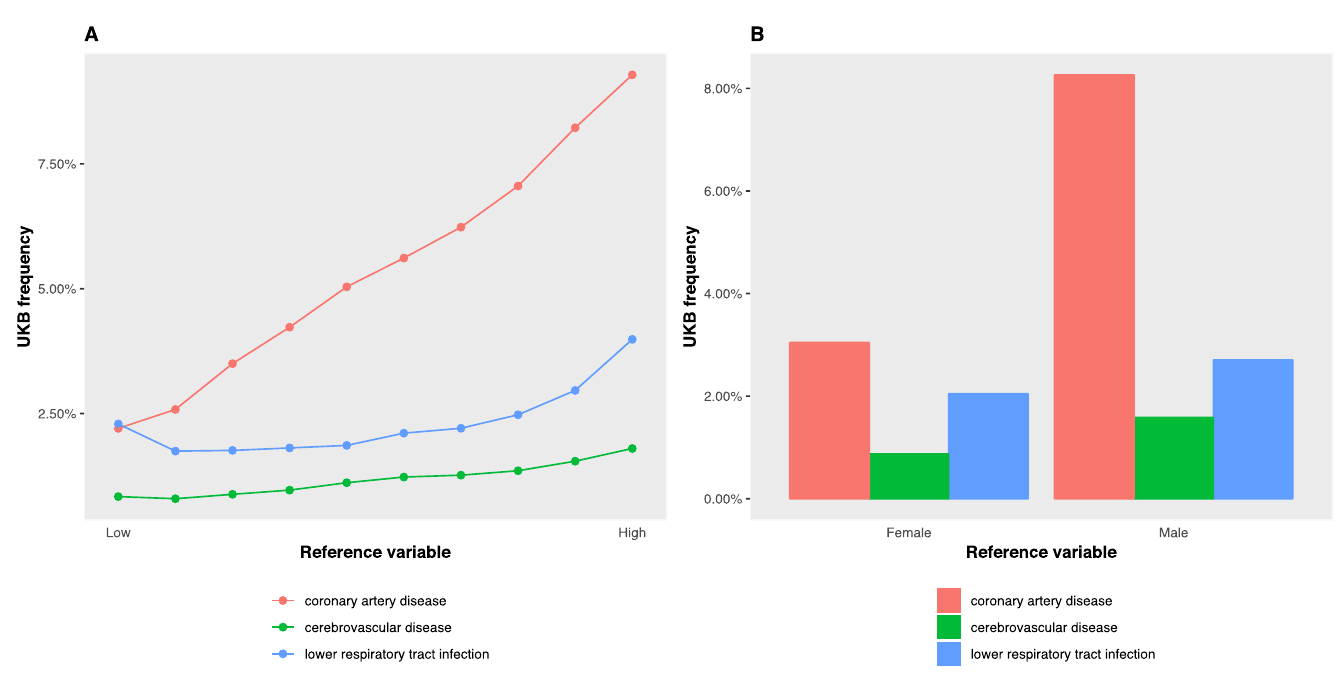
Fig 2. UKB disease frequency by BMI (quantitative) and sex (categorical) reference traits. In panel A the reference trait is body mass index, set with the ukb_icd_freq_by argument reference.var = "body_mass_index_bmi_f21001_0_0". Disease frequency is calculated within 10 approximately equal-sized groups (n. group = 10). In Panel B the reference trait is sex, reference.var = "sex_f31_0_0". Default ICD codes correspond to the World Health Organization (WHO) 2015 top 3 causes of death globally: "coronary artery disease", "cerebrovascular disease ", and "lower respiratory tract infection". These are supplied to ukb_icd_freq_by as a character vector of regular expressions, icd.code = c("^(I2[0–5])", "^(I6[0–9])",